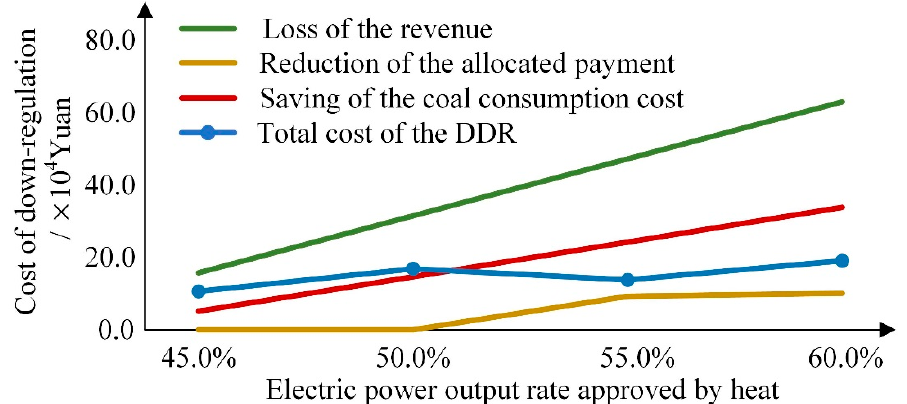
Figure 7. The relationship between the approved power output rate of the CHP plant and the total cost for the DDR.